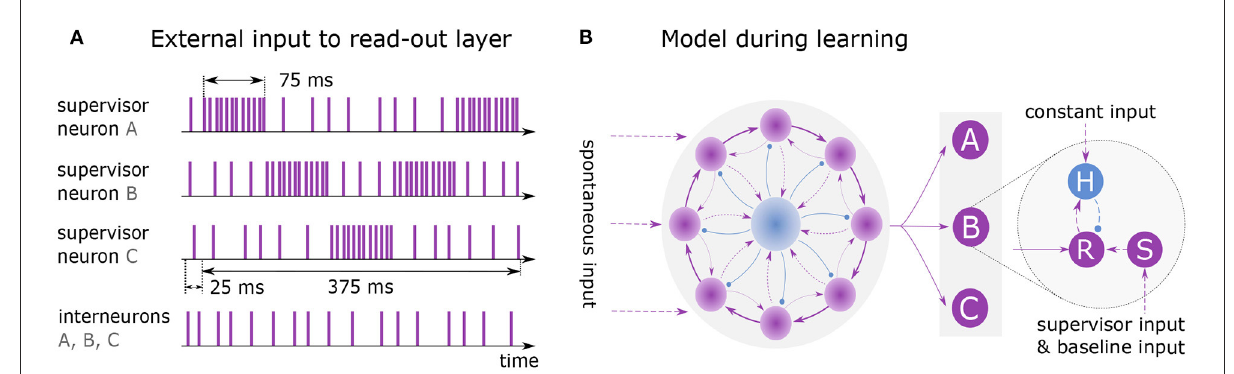
FIGURE3 Learning and replaying a sequence. (A) External spike trains to supervisor neurons and interneurons during learning of sequence ABCBA . A single presentation is shown with total duration of 400 ms including 25 ms lead time. Each element is presented for 75 ms by stimulating the associated supervisor neuron with rate 10k spks / sec. When an element is not presented, its supervisor neuron receives input at baseline rate 1k spks / sec. (B) Model architecture while learning the sequence. Clock is all-to-all connected to the read-out layer. Units A , B and C each consist of three neurons: read-out (R), supervisor (S) and interneuron